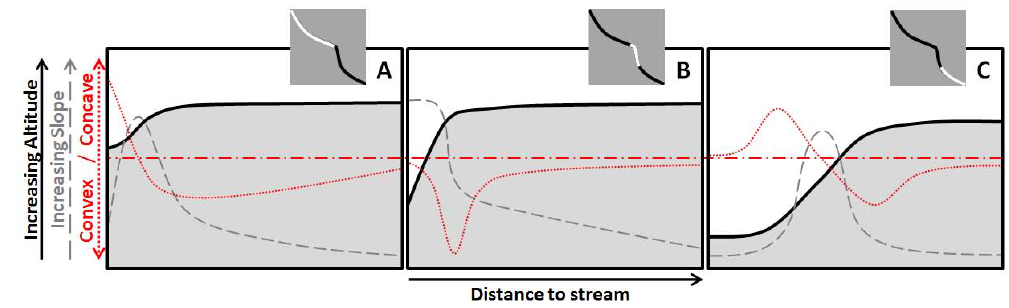
Fig. 6. Schematic representation of the change in hill slope morphology measured perpendicular to the river channel for three different positions: (A) upstream the river channel knick zone, (B) in the knick zone and (C) downstream the knick zone. The valley cross profiles are shown by the black line, the changes in stream proximal slopes by the dashed grey line and the stream proximal curvature by the red dotted